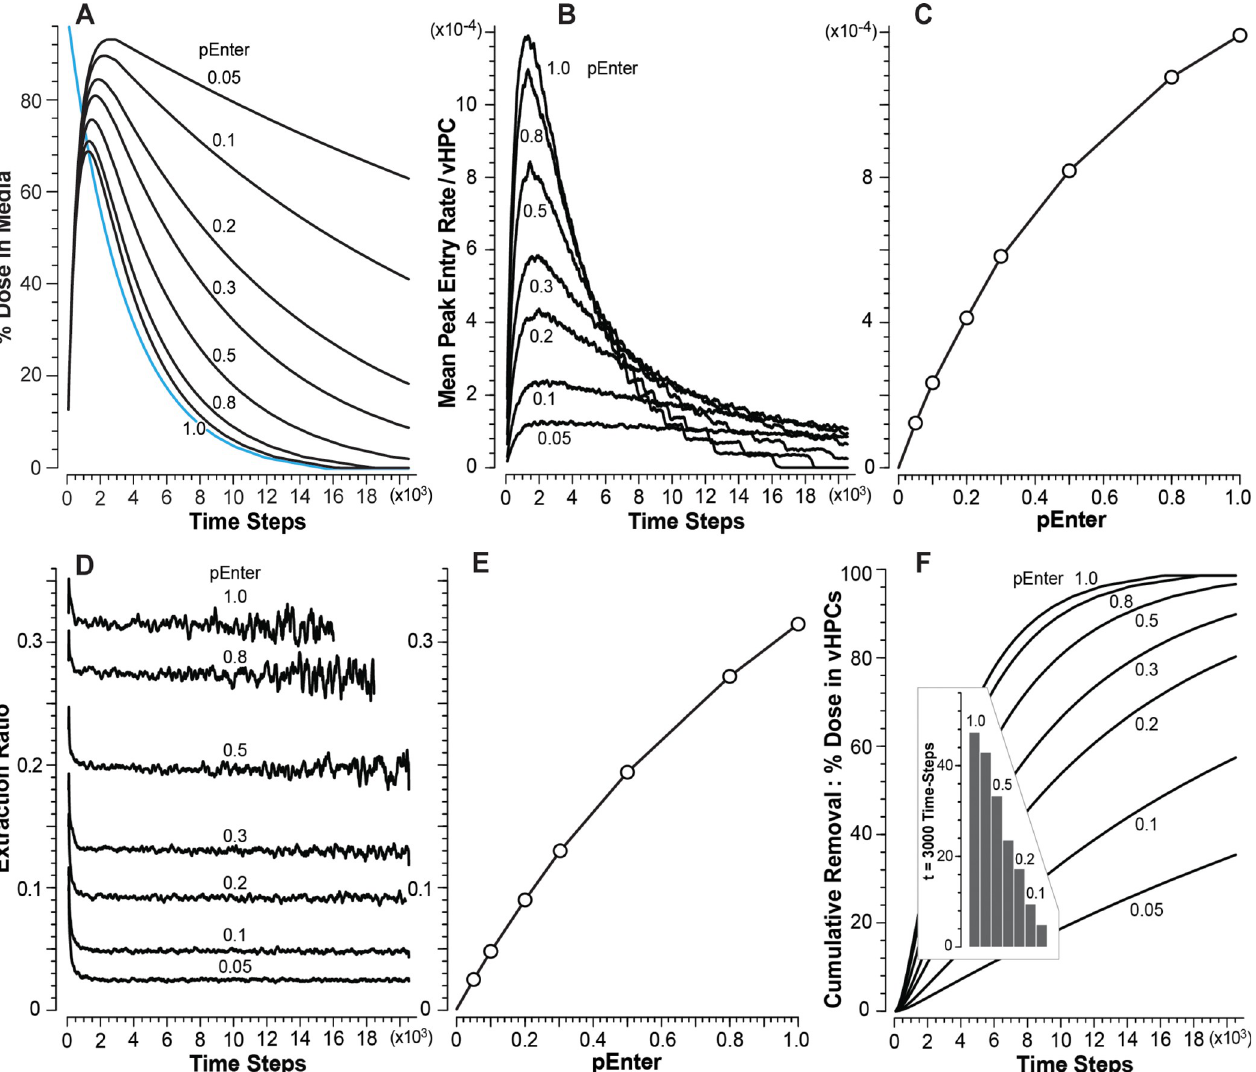
Fig 6. Results from vCulture experiments using vC2. (A) Temporal measures of percent Dose in Media for each pEnter . Blue profile: added all vC2 to Media at t = 0. (B) Mean removal rates for each pEnter (Entry rates = removal rates). (C) Correlation between mean peak Entry rates and pEnter . (D) Temporal measures of Extraction Ratio for each pEnter . Average variance increases with time because smaller amounts are measured each TS. Extraction Ratios for pEnter = 1.0 and 0.8 terminate because (essentially) all vC2 has been removed. (E) Correlation between mean plateau Extraction Ratios and pEnter . (F) Temporal measures of cumulative percent Dose in vHPCs for each pEnter . Insert: mean values at t = 3,000 TS for each pEnter